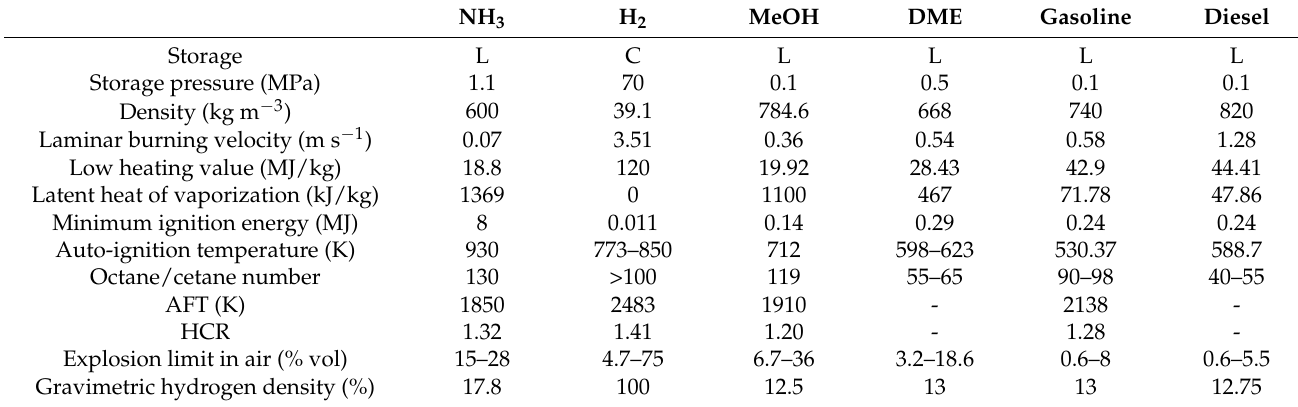
Table 11. Comparison of NH 3 combustion properties with other fuels at 27 ◦ C